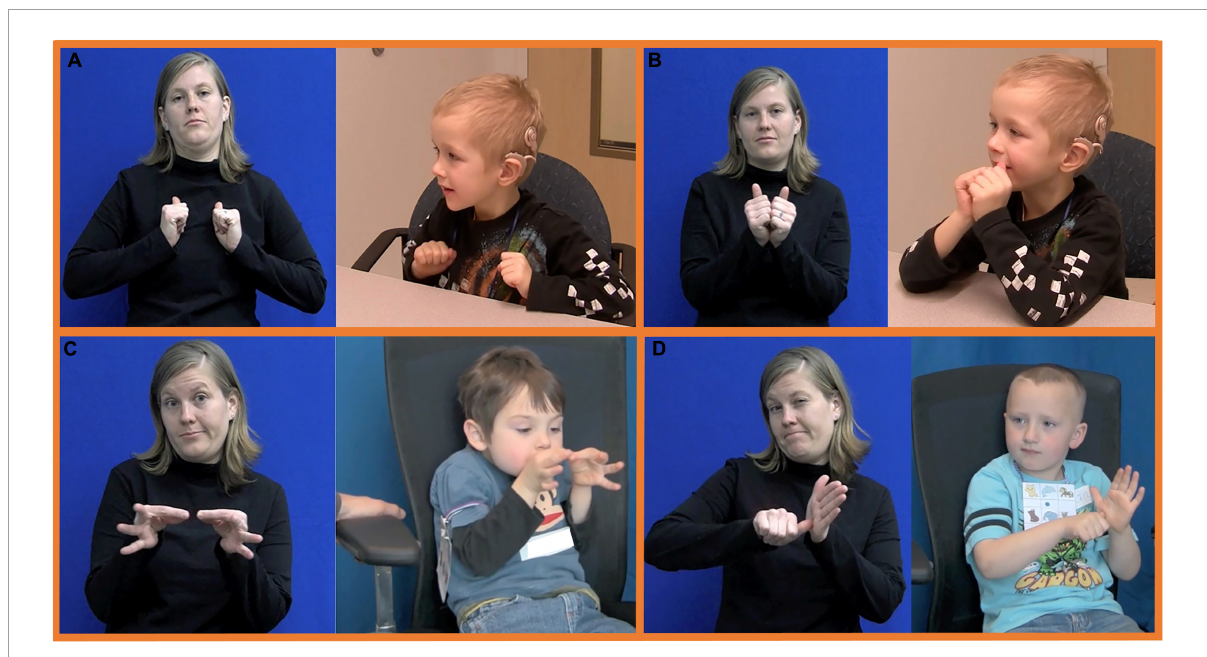
FIGURE4 Target form and child form. (A) Thumb position; (B) height in neutral space; (C) height in neutral space; and (D) fingertips orientation of the non-dominant hand.